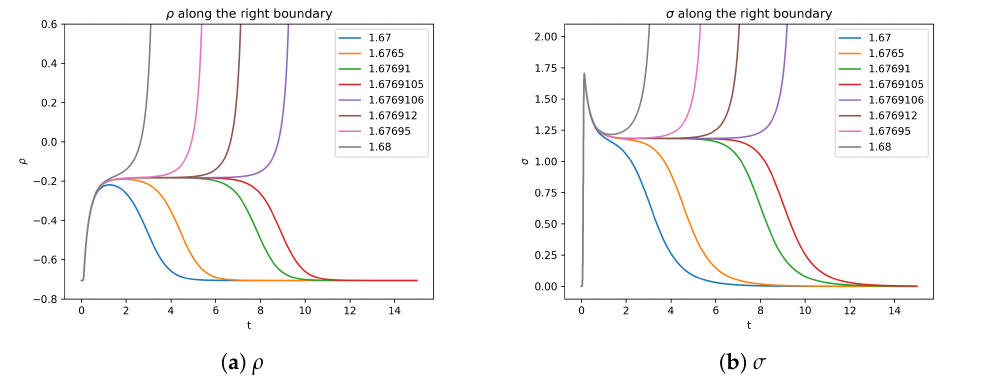
Figure 6. Plots of ρ and σ along the right boundary for different wave areas close to a c . The curves corresponding to the first four values of a from smallest to largest are the curves asymptoting back to their initial values from left to right. The curves corresponding to the larger four values of a from smallest to largest are the curves which diverge from right to